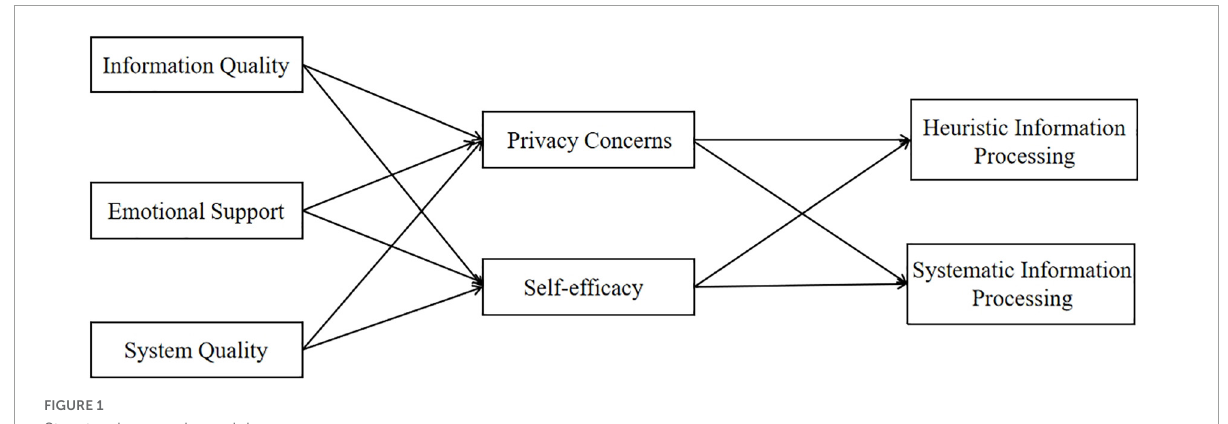
FIGURE1 Structural research model.